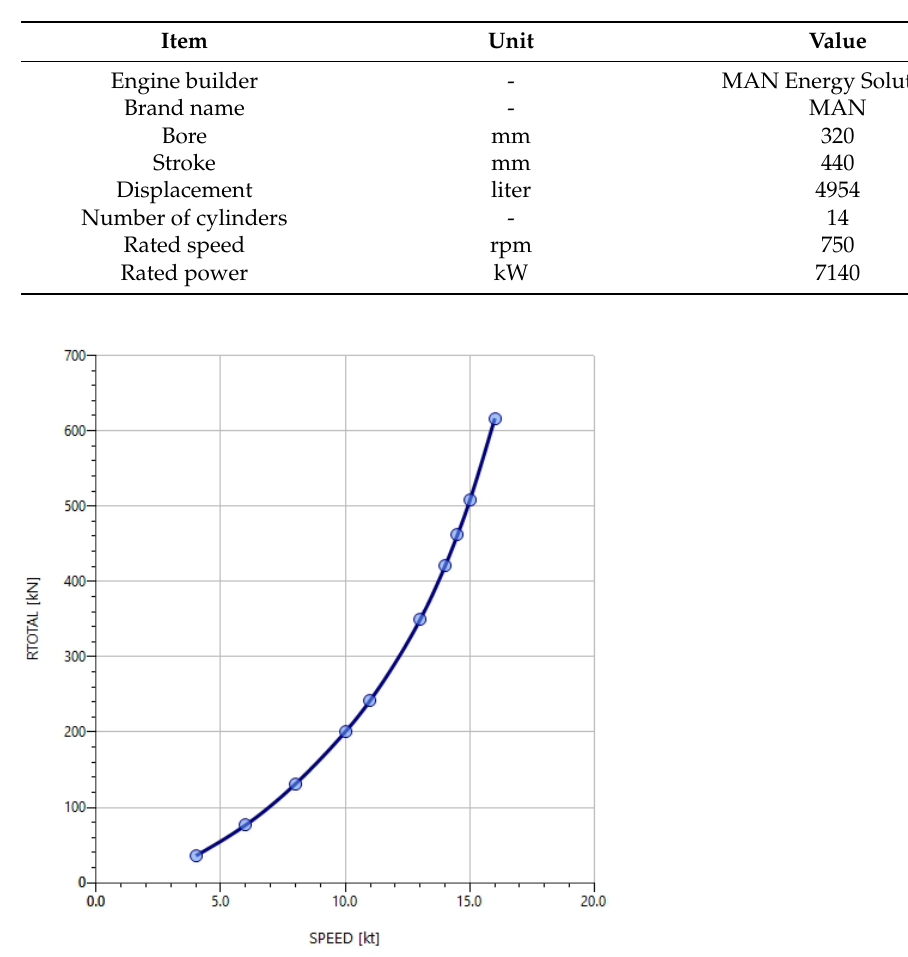
Table 2. Main characteristics of MAN 14V 32/44 CR.